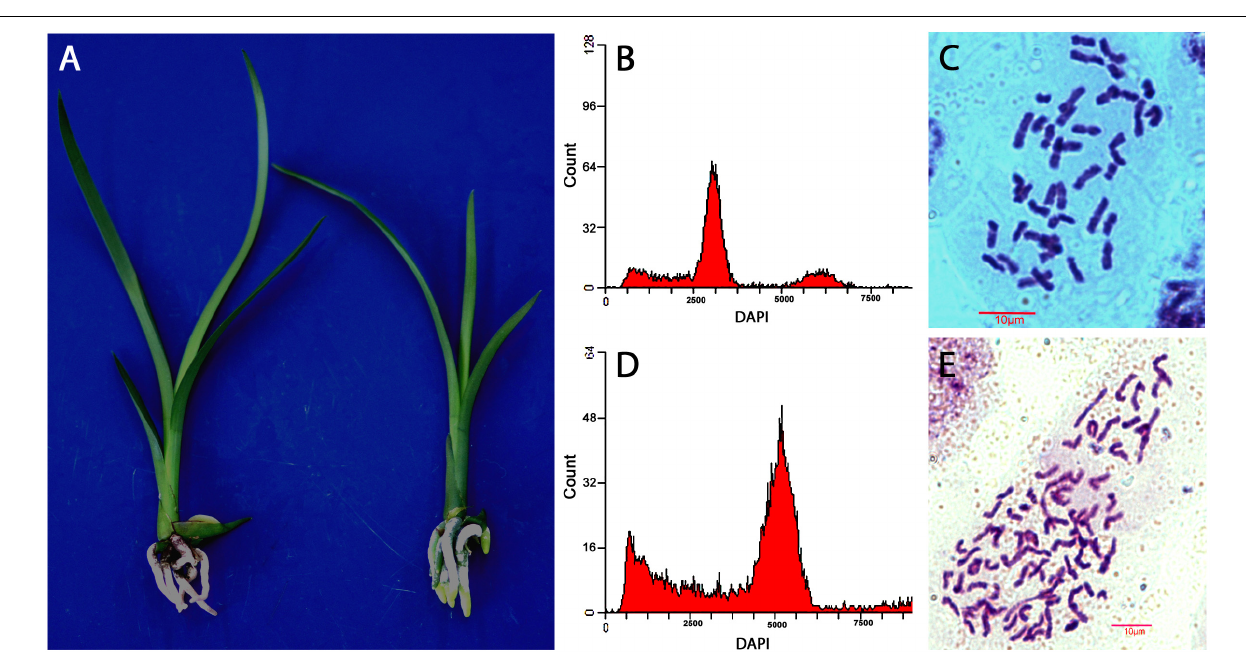
FIGURE 3 | Evaluation of ploidy levels of Cymbidium hybrids of “XY” and “Yutao” developed from cross of “Yunv” × “Xiaoxiang.” (A) Morphology of “YX” (left) and “Yutao” (right). (B) Flow cytometric DNA histograms of “YX” and (C) chromosome numbers of root tip cell of “YX” (2 n = 2 x = 40). (D) Flow cytometric DNA histograms of “Yutao” and (E) chromosome numbers of root tip cell of “Yutao” (2 n = 3 x =